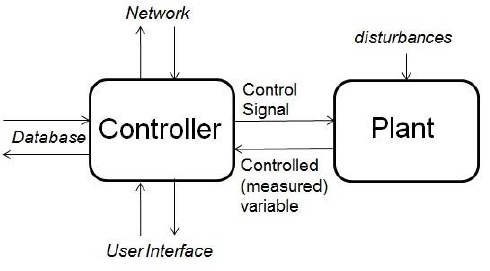
Figure 4. Illustration of interactions in a modern control system.